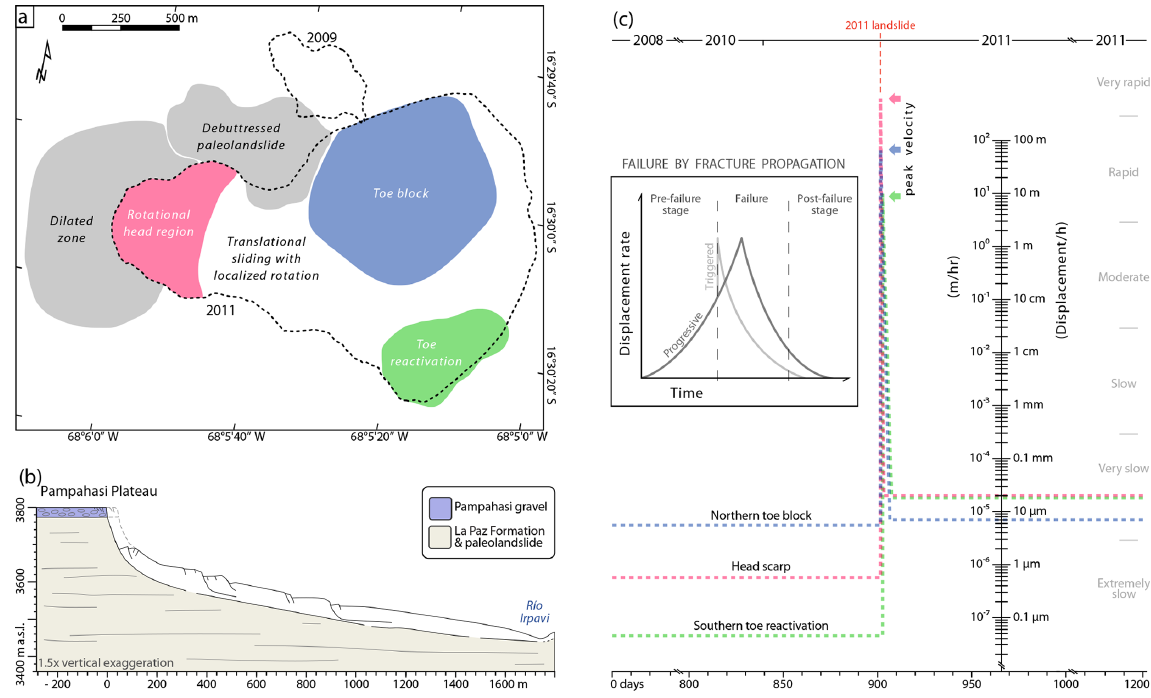
Figure 11. Proposed geomechanical model for the Pampahasi landslide and adjacent terrain. (a) Components of failure, which differ in kinematics and activity history. (b) Generalized section through the failing slope illustrating the approximate depth and attitude of the failure zone. The topographic surface is based on NASA’s Shuttle Radar Topographic Mission v3.0, which depicts the generalized pre- failure terrain. Dashed and solid lines in the source area (0 to ∼ 150m x -axis distance) represent, respectively, pre-failure topography and post-failure topography based on terrain changes measured in the field using a handheld laser rangefinder. Terrain lower on the failed slope changed comparatively little during the landslide; the solid line beyond ∼ 150m x -axis distance is thus generally representative of both the pre-failure and post-failure topography. (c) Schematic temporal displacement history generalized from InSAR measurements bracketing the 2011 Pampahasi landslide and eyewitness accounts. Due to the revisit frequency of RADARSAT-2 (24 days), the lack of acceleration leading up to the 2011 Pampahasi landslide is based on the lack of such effects reported by local residents. Velocity classes are from Cruden and Varnes (1996), spanning all classes except for “extremely rapid” (>5ms − 1 ). The inset shows schematic stages of slope movement during first-time failure by fracture propagation (after Hermanns and Longva,